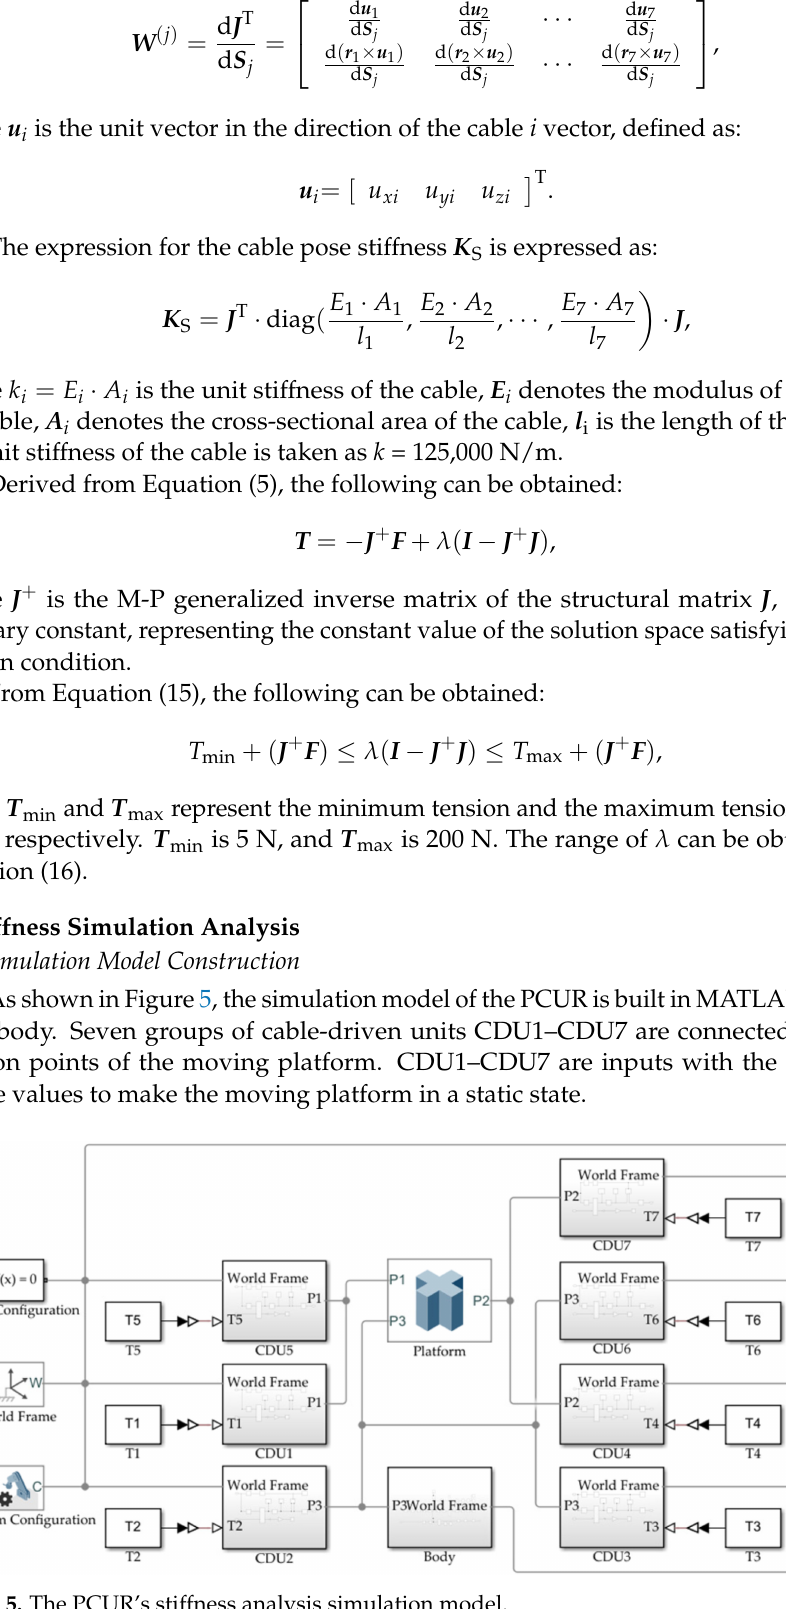
Figure 5. The PCUR’s stiffness analysis simulation